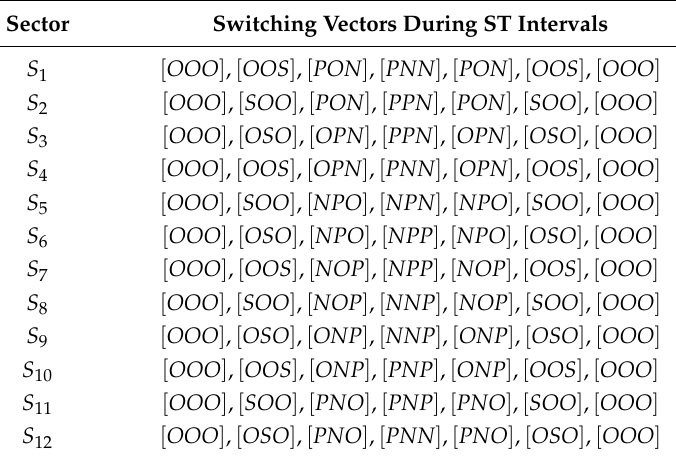
Table 4. Switching vectors during ST